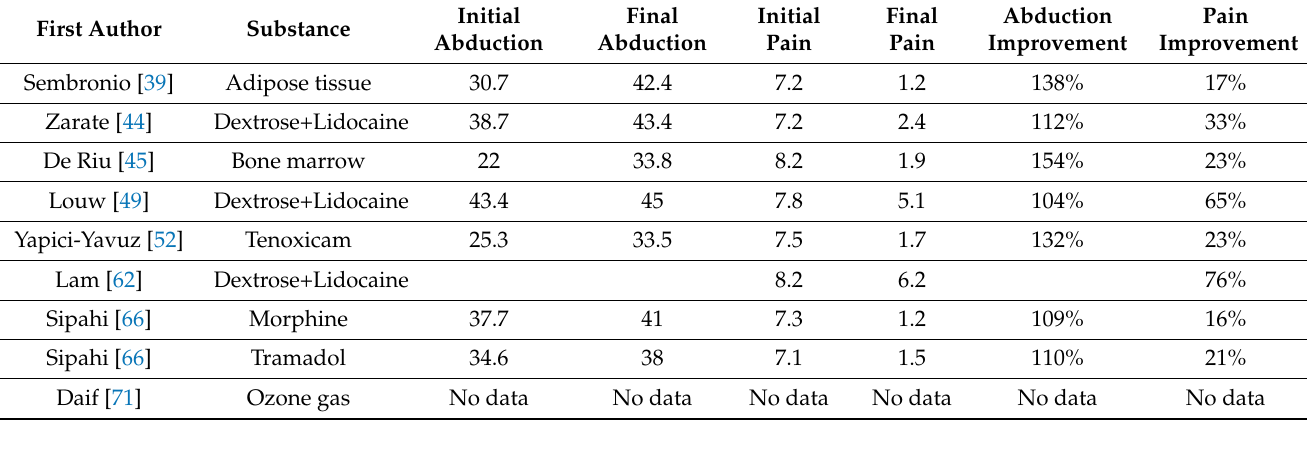
Table 5. Quantitative analysis.